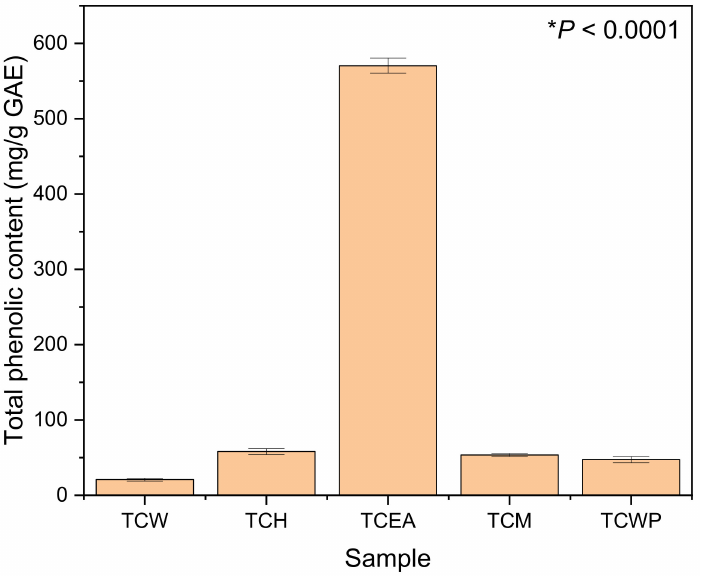
Figure 1. Total phenolic content of cocoa pod husk extracts. (*) statistically significant at p < 0.05 based on one-way